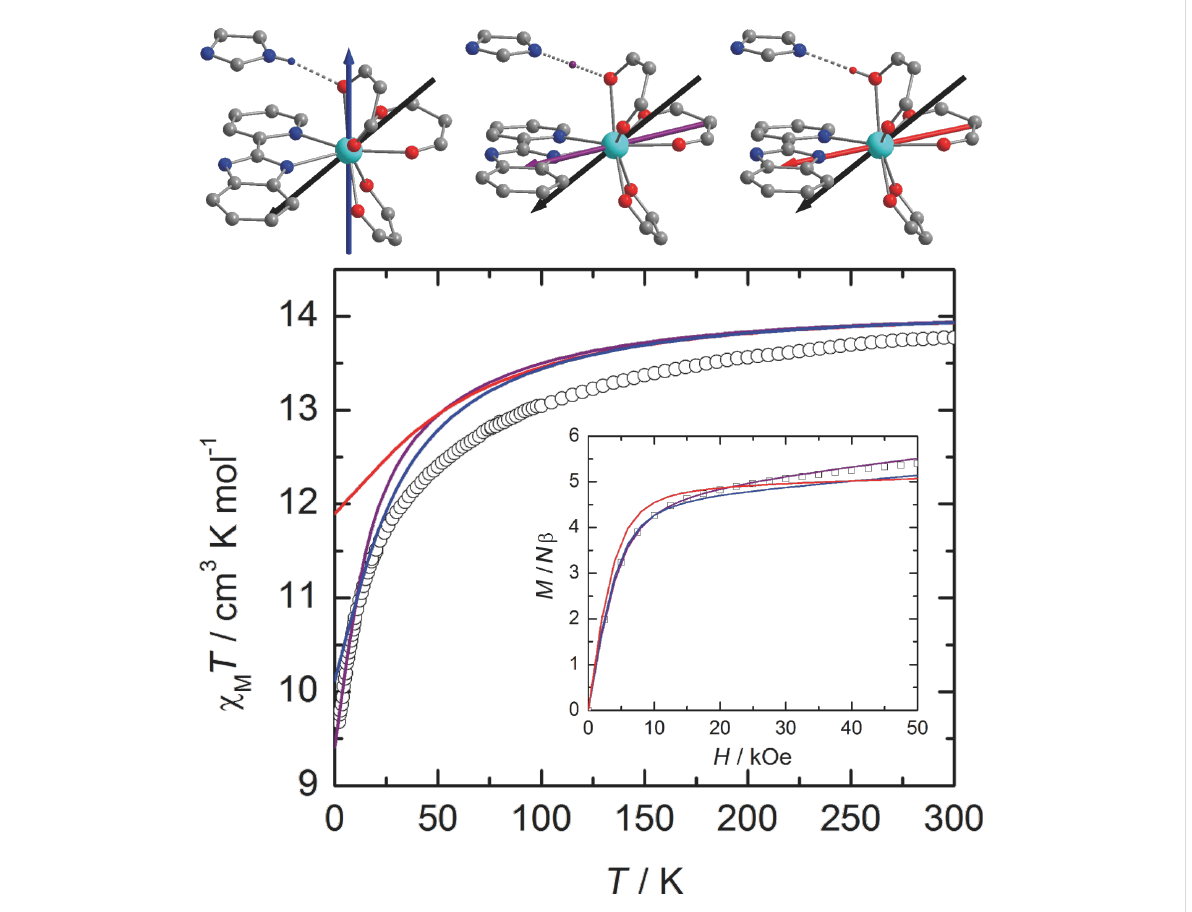
Figure 4: Orientation of the experimental (black) and calculated ground-state anisotropy axes for Dy1 (top). The orientation of the calculated axis is given for the different positions of the hydrogen atom involved in the hydrogen bond, i.e., from left to right: H N (blue), H m (purple) and H O (red). Thermal variation of χ M T of a solid-state sample of Dy1 (black circles) with the curve calculated on the basis of SA-CASSCF/RASSI-SO data for the various positions of the H atom (bottom). Inset: field variation of the magnetization at 2 K (black squares) with the computed curve obtained at the same level of